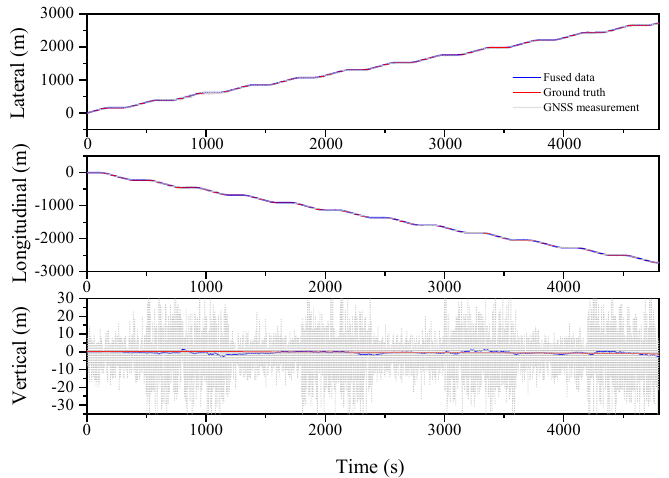
Figure 10. Lateral, Longitudinal and Vertical positions of EKF (Serpentine 2).